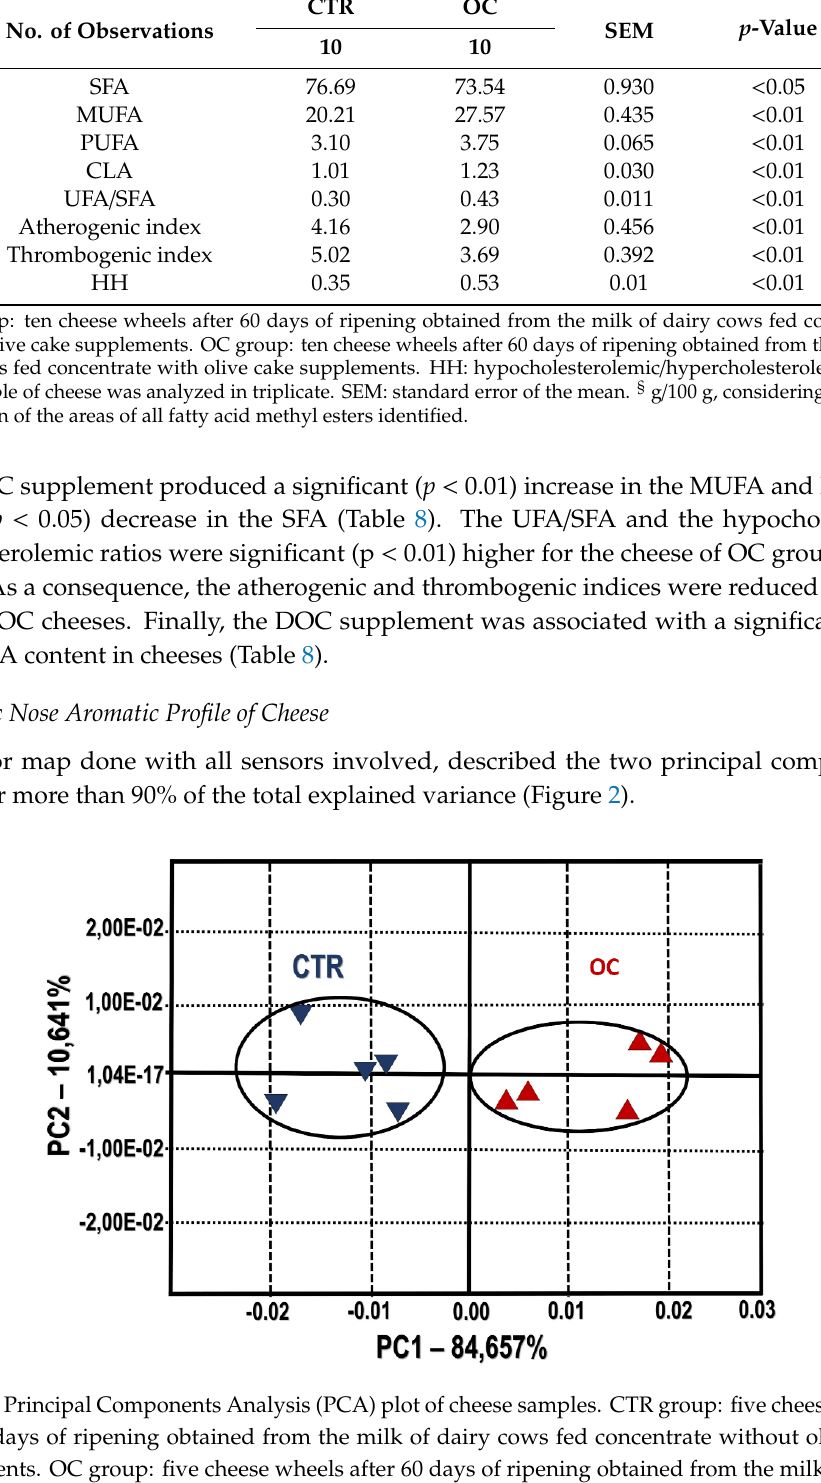
Table 8. E ff ect of olive cake supplement on cheese fatty acid classes (g / 100 g) § and nutritional indices after 60 days of ripening.